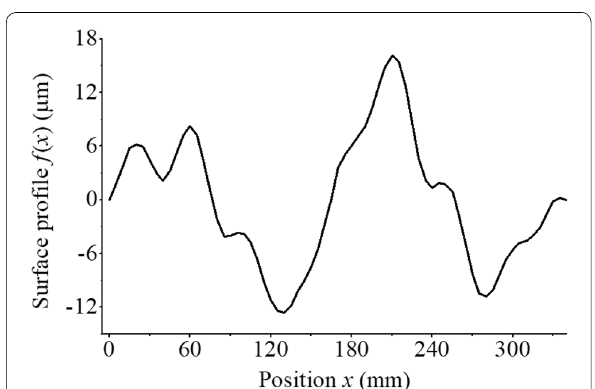
Figure 10 Surface profile obtained by the new four-sensor